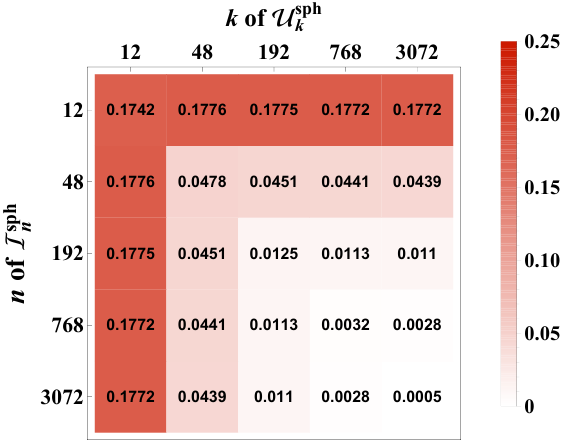
Figure 12 . The event isotropy I sph